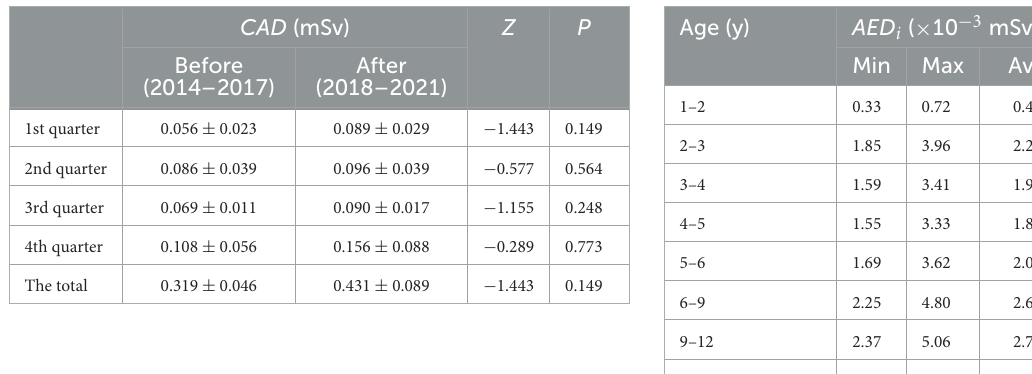
TABLE 8 Age-dependent AED i and ER i induced by the ingestion of drinking water (tap water) for the population around SNPP from 2014 to